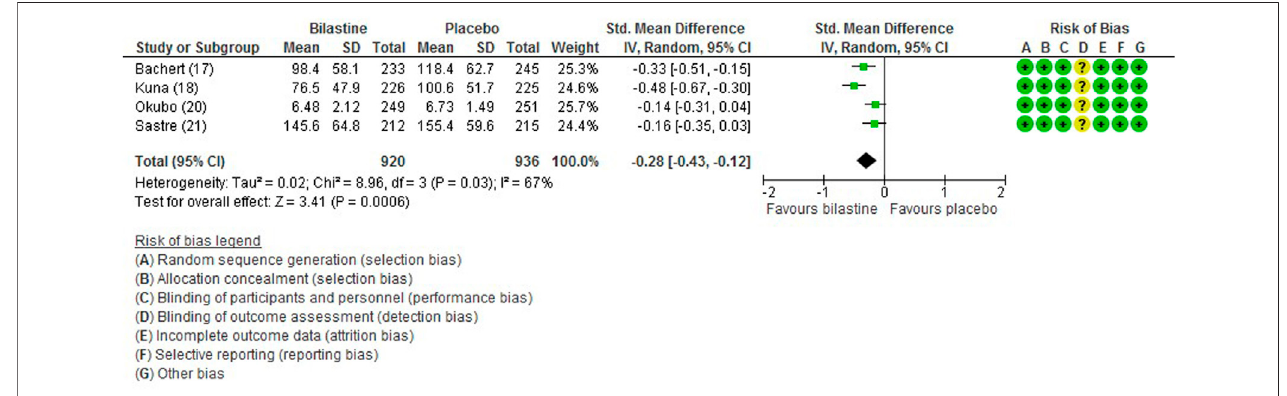
FIGURE3| Comparisonbetweenbilastineandplacebofortotalsymptomscore. Std Standard, SD Standarddeviation, IV inversevariance, CI Con fi denceinterval, df degrees of freedom.